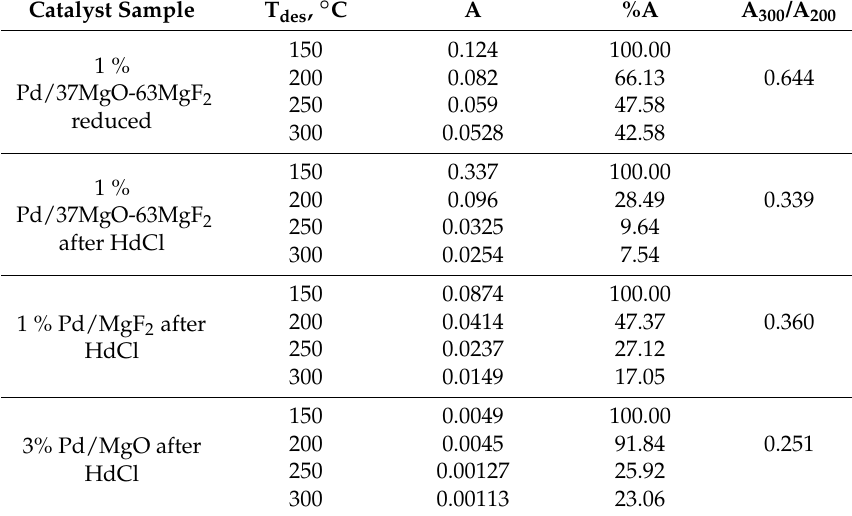
Table 4. Desorption of pyridine from 1 wt% Pd/MgO-MgF 2 , 1 wt % Pd/MgF 2 and 3 wt %